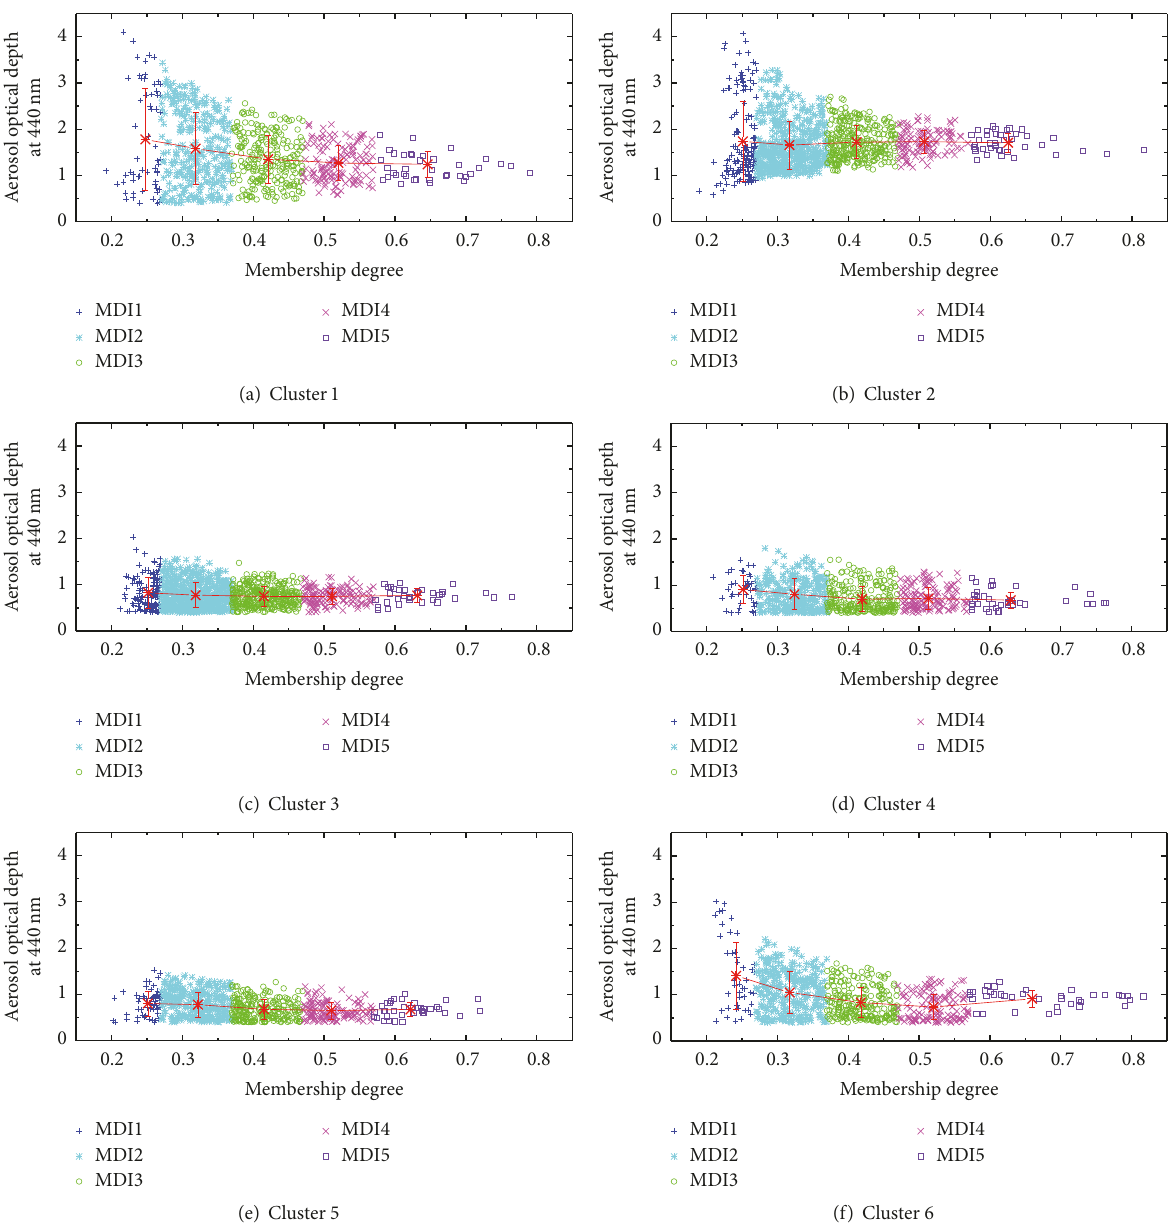
Figure 9: AODs at 440 nm with membership degrees: asterisk represents mean value of AOD in each interval, and the vertical bars represent the standard